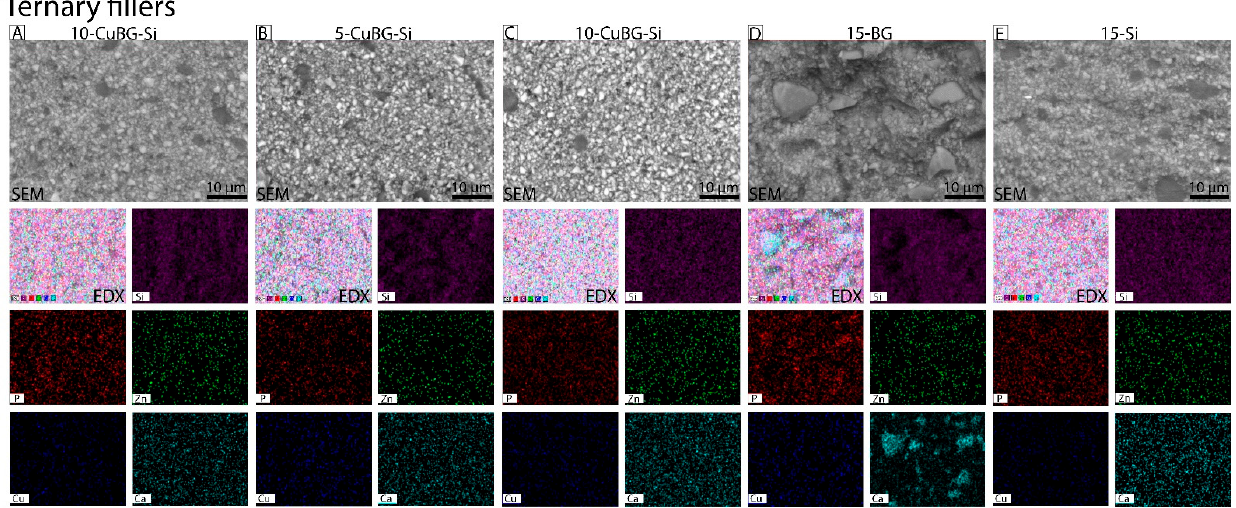
Figure 2. Representative surface morphology and elemental mapping images of the Ternary filler group by SEM-EDX. ( A ) 1-CuBG-Si, ( B ) 5-CuBG-Si, ( C ) 10-CuBG-Si, ( D ) 15-BG, and ( E ) 15-Si. SEM- EDX images were taken after 28 days of experimental composites immersed in HEPES buffer (pH = 6.5), and the elements identified were silica (Si) in purple, phosphorous (P) in red, zinc (Zn) in green, copper (Cu) in blue, and calcium (Ca) in light blue. The scale bar corresponds to 10 μ m in all micrographs.